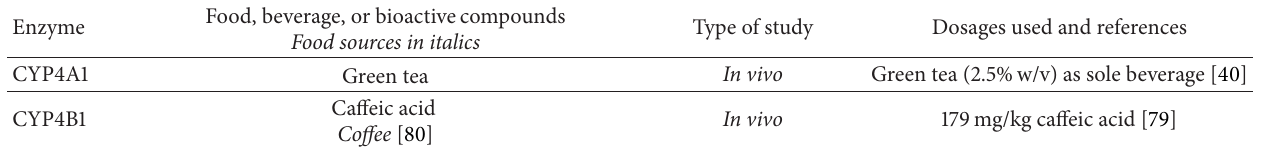
Table 4: Human and in vivo example nutrient inducers of selected CYP4